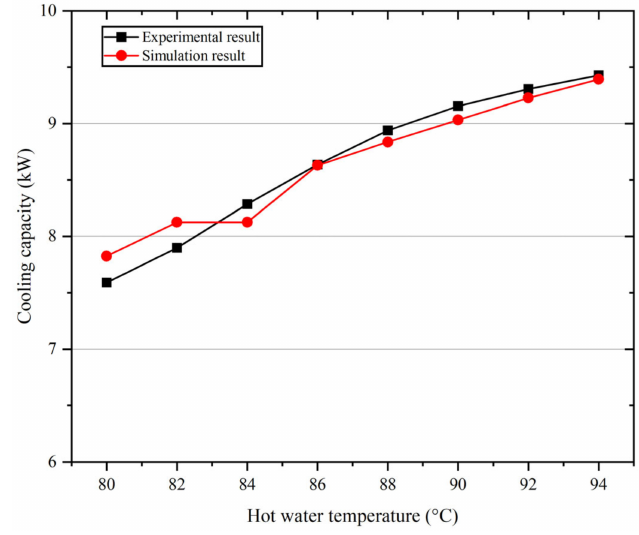
Figure 9. Comparison of simulation and reference results of AC.